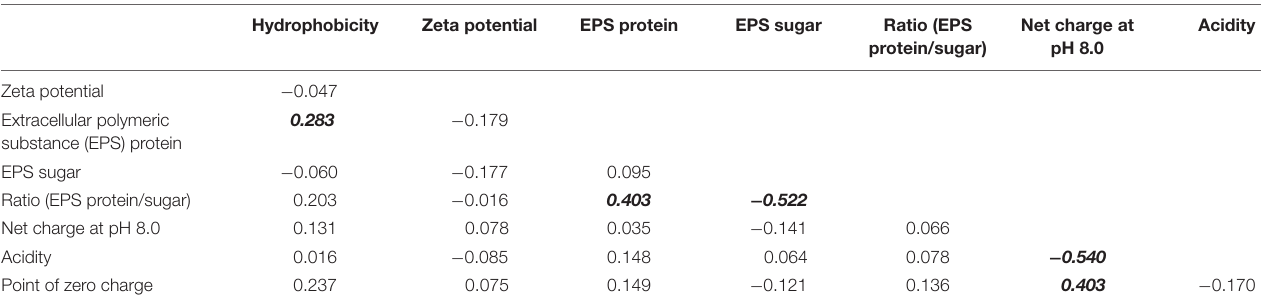
TABLE 1 | Correlation coefficient matrix for cell properties for all E. coli strains ( n = 77) obtained from Kendall-tau correlation